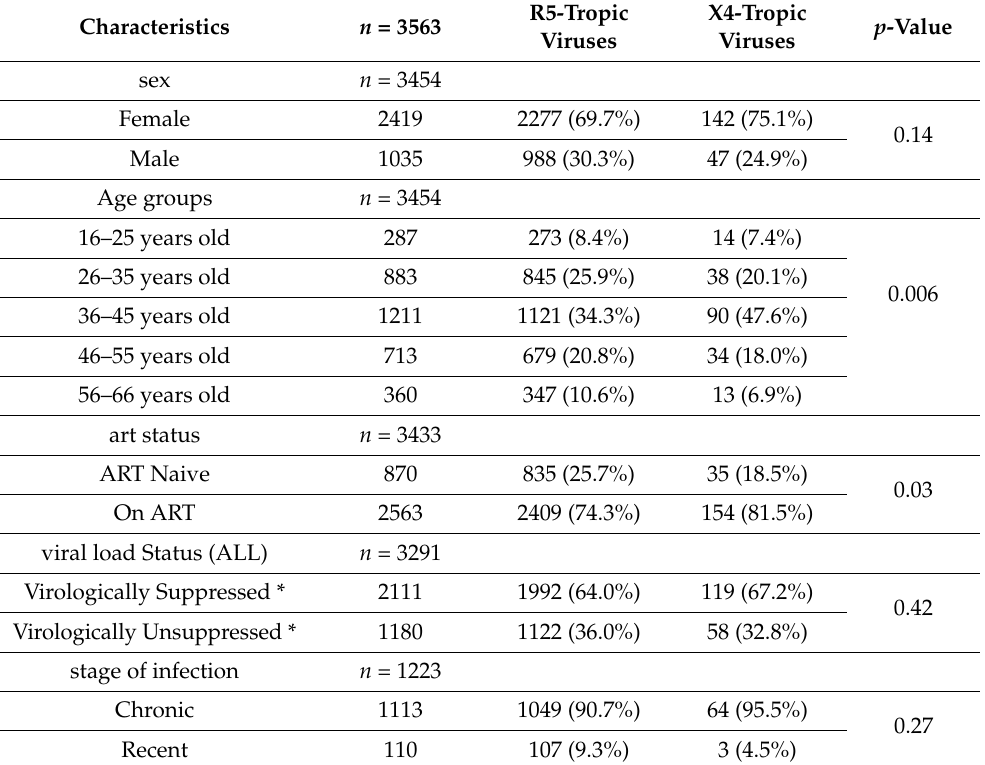
Table 3. Characteristics of the PLWH with congruent tropism predicted by the three tools.